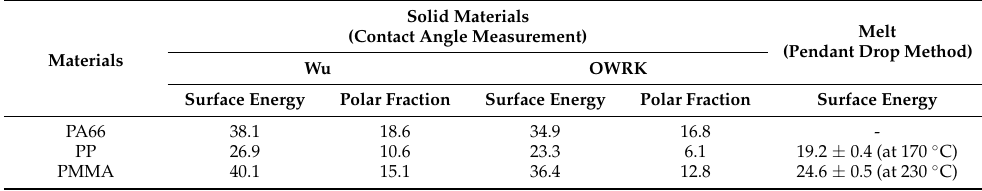
Table 3. Surface energy and polar fraction of the materials in [mN/m].